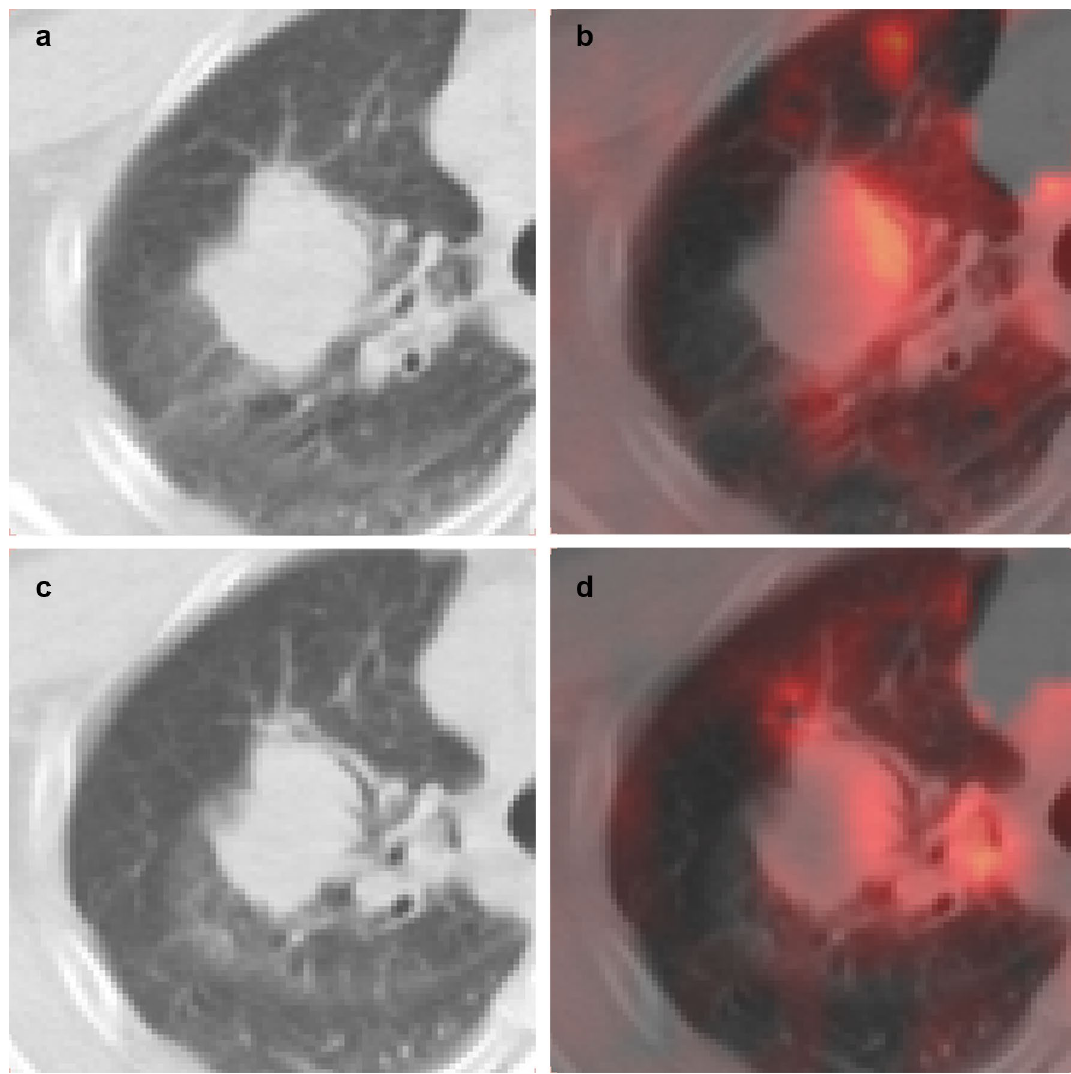
Figure 4. 15 O-water PET image of a 62-year-old man with adenocarcinoma treated with bevacizumab (patient no.1). ( a,b ) CT and fusion image of CT and parametric image of blood flow at baseline. ( c,d ) CT and fusion image after chemotherapy. The CT showed a 4.4 cm large mass in the right lung. Tumor blood flow